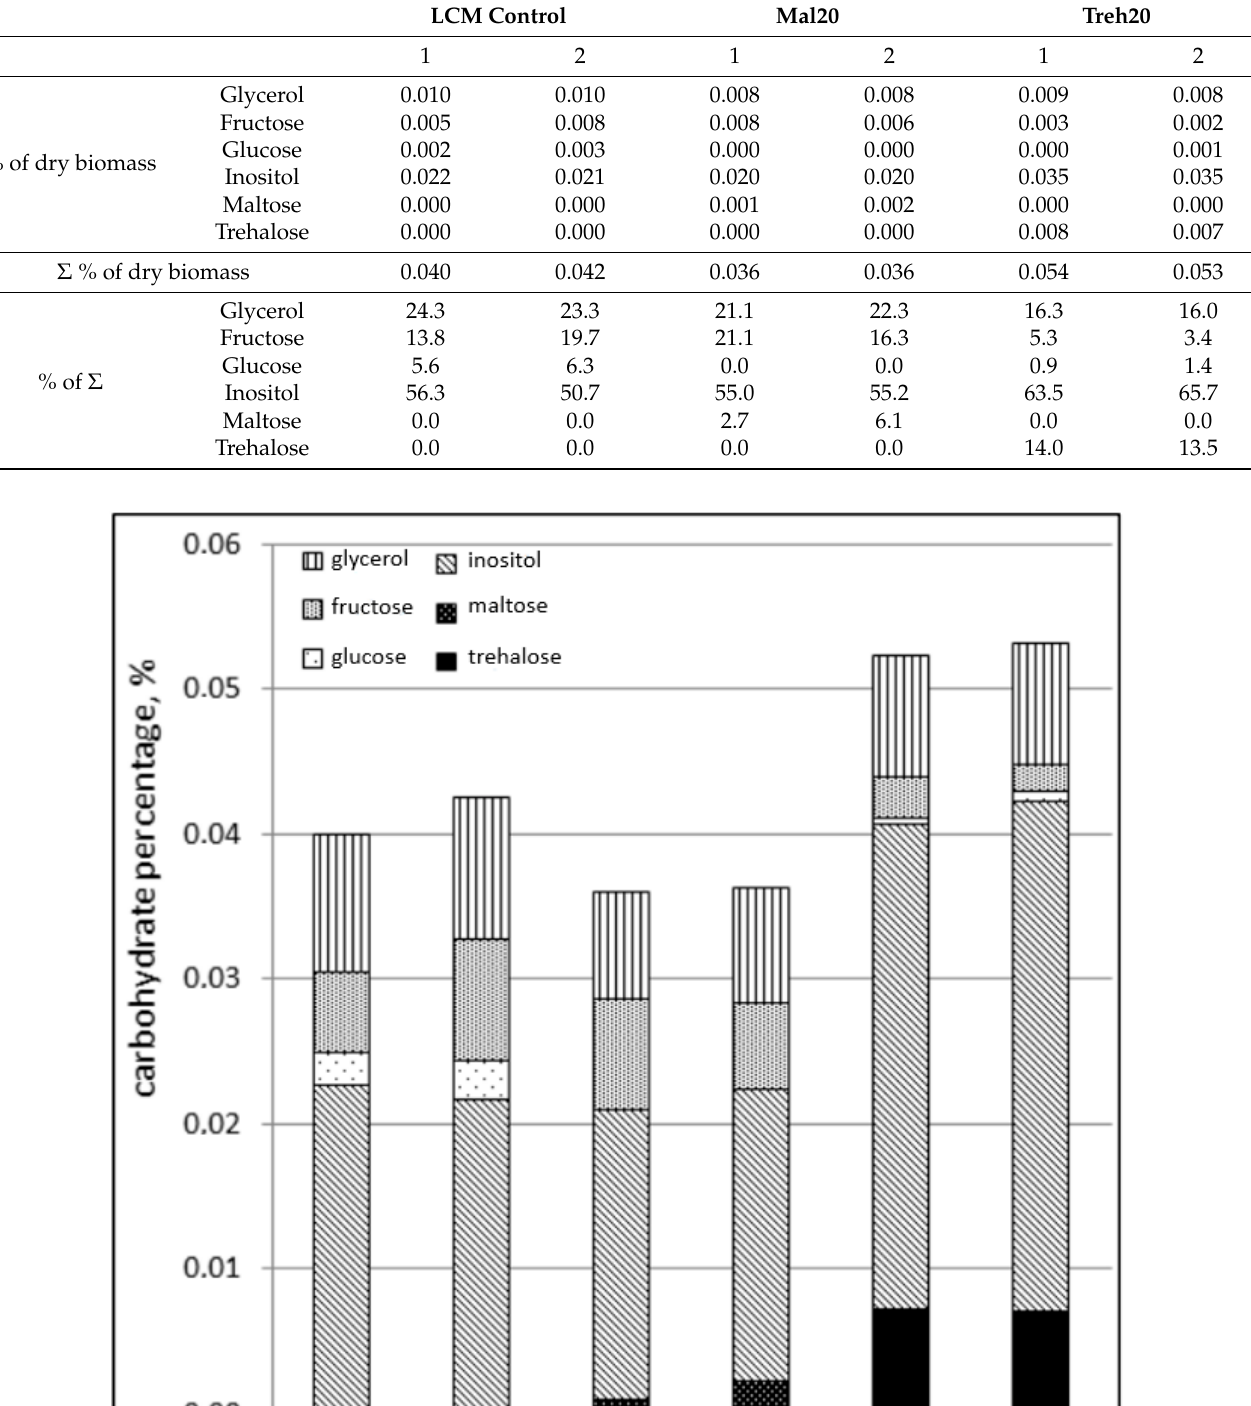
Table 2. Results of the analysis of the quantitative composition of carbohydrates (glucose, inositol, trehalose, maltose, and fructose) and glycerol in the spermatozoa of roosters (in duplicate).